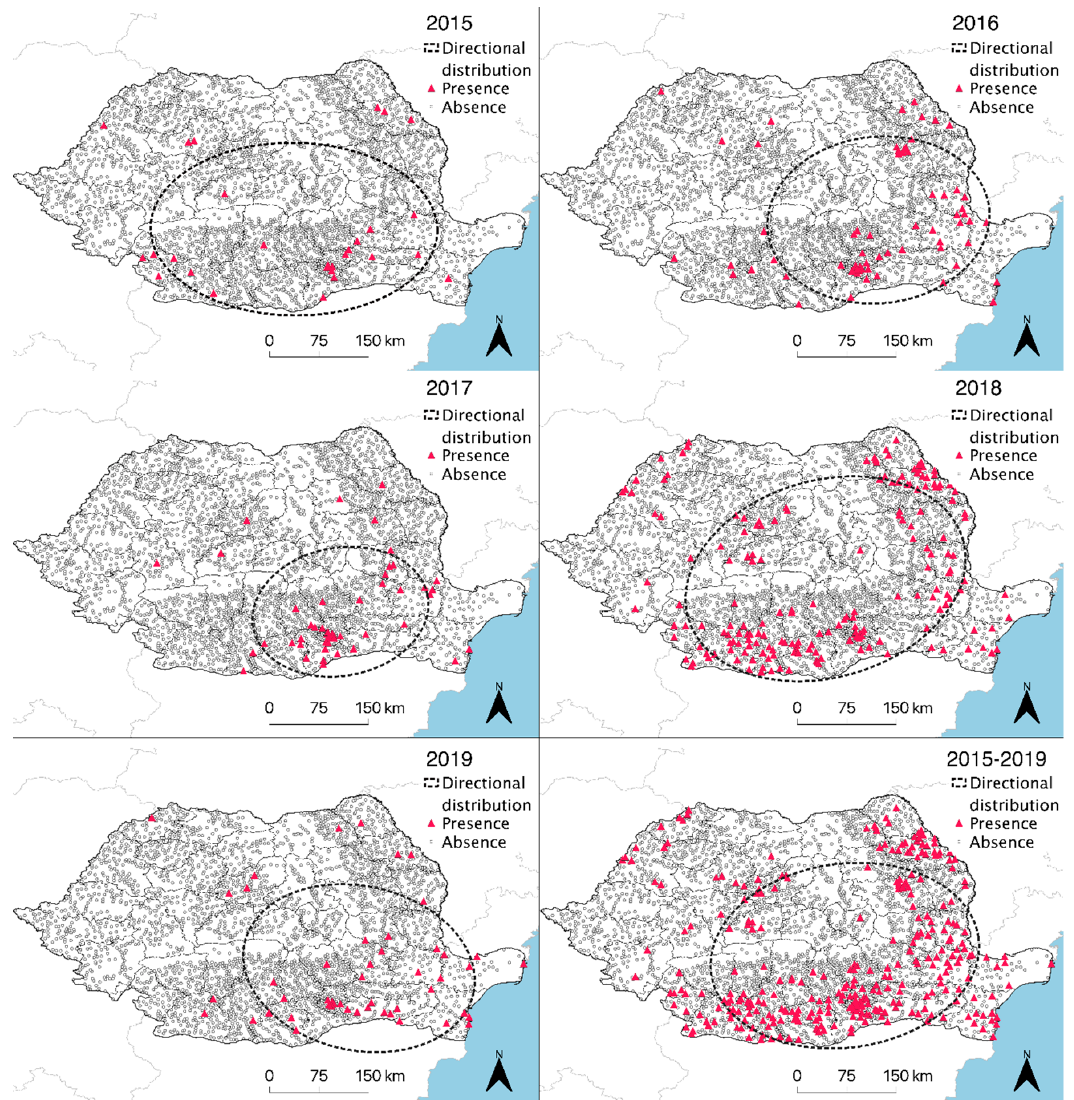
Figure 2. Directional distribution of human WNND cases in Romania between 2015 and 2019.